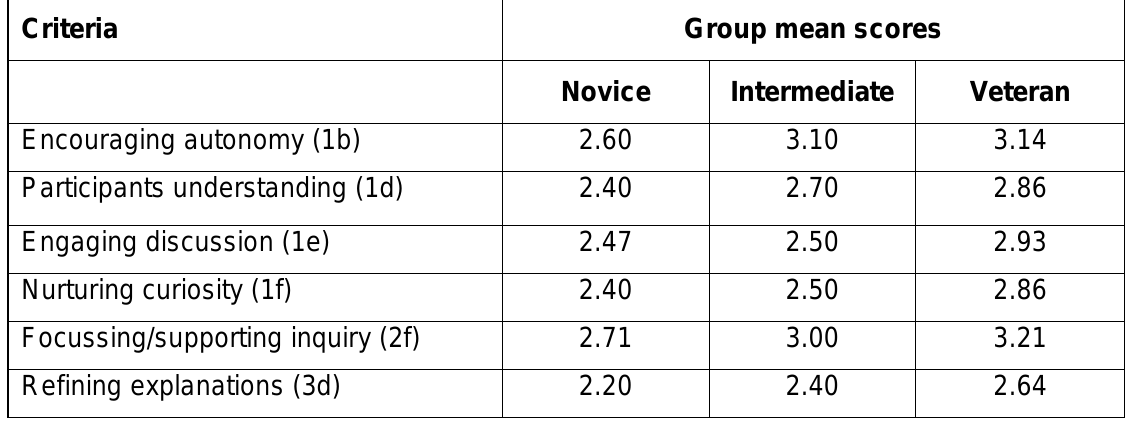
Table 6. Comparison of statistically significant different mean scores for criteria observed during facilitation of Family Maths workshops.